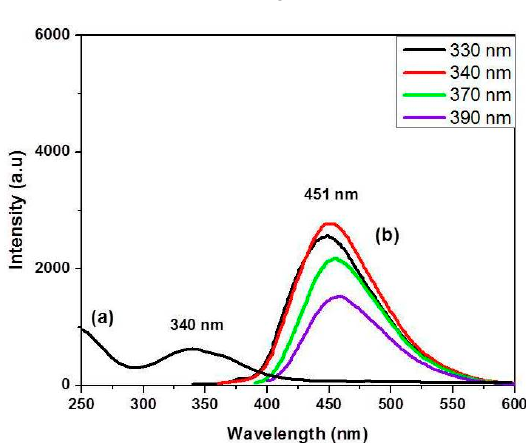
Figure 3. UV-Vis ( a ) and PL ( b ) spectra of CD CA-TETA dispersed in water.